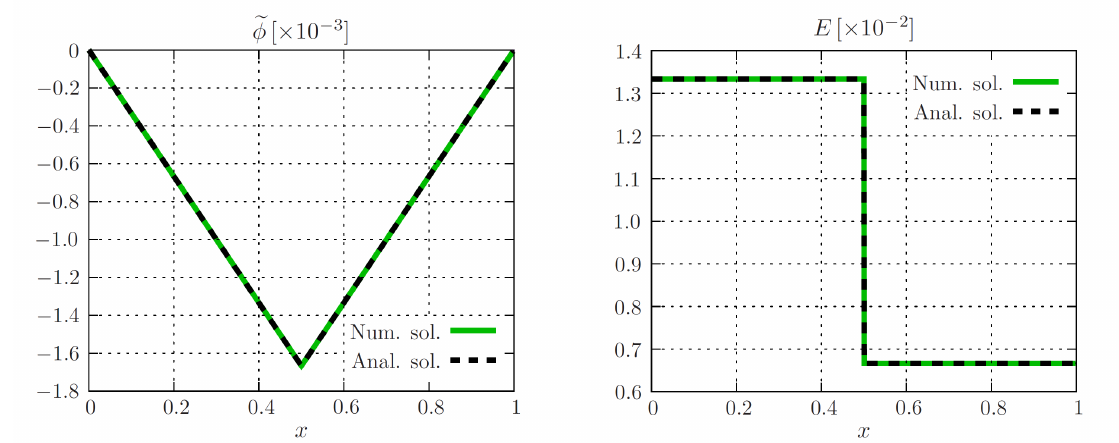
Figure 5. Numerical vs. analytical solution for 2 SLPs with 10 neurons each and a random initialization ∗ U ( 0,1 ) , where U ( 0,1 ) denotes a vector of numbers generated from a uniform of p ( 0 ) , ∗ ∼ E H distribution between 0 and 1. These parameters are statistically